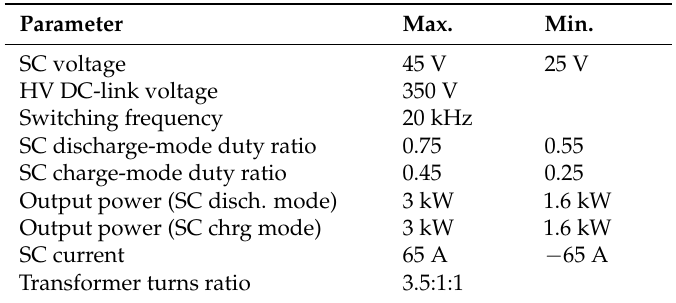
Table 1. Characteristics of half-bridge current-source (HBCS)